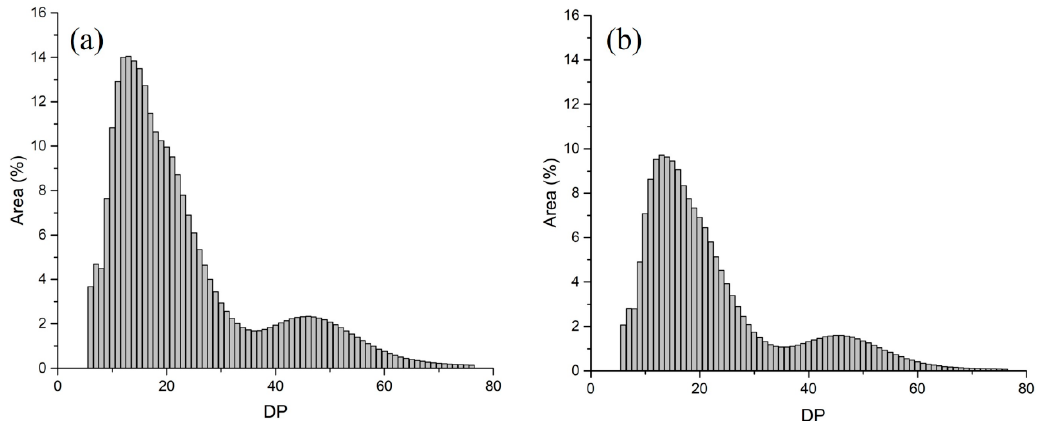
(Table 3). This result indicated that starch of sub-1 mutant has more branches (i.e., 1, 6- glycosidic bond form).